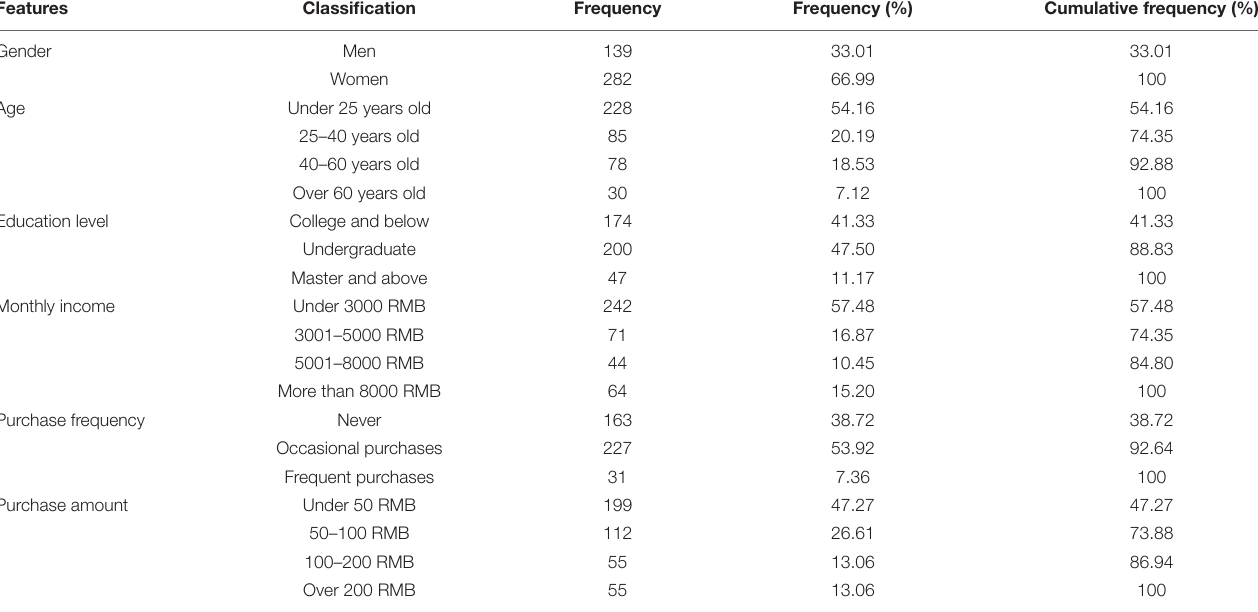
TABLE 1 | Frequency distribution